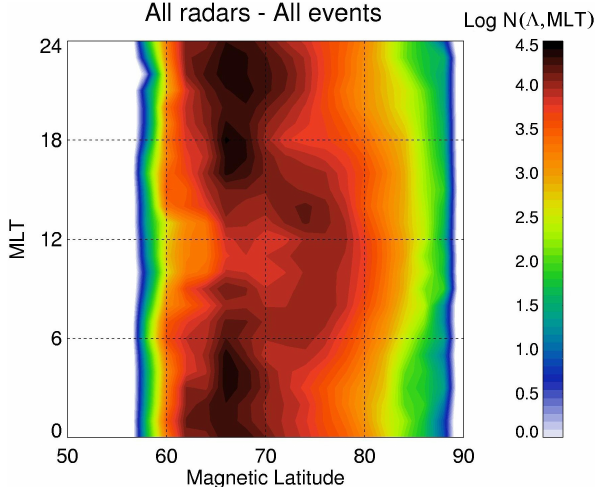
Fig. 3. Isocontours of the number of echoes summed over all radars, events and two-min bins, in cells of 2 ◦ Magnetic Latitude, 3 ( x axis), and one hour MLT ( y axis). The log-number of echoes is coded according to the color scale on the right.